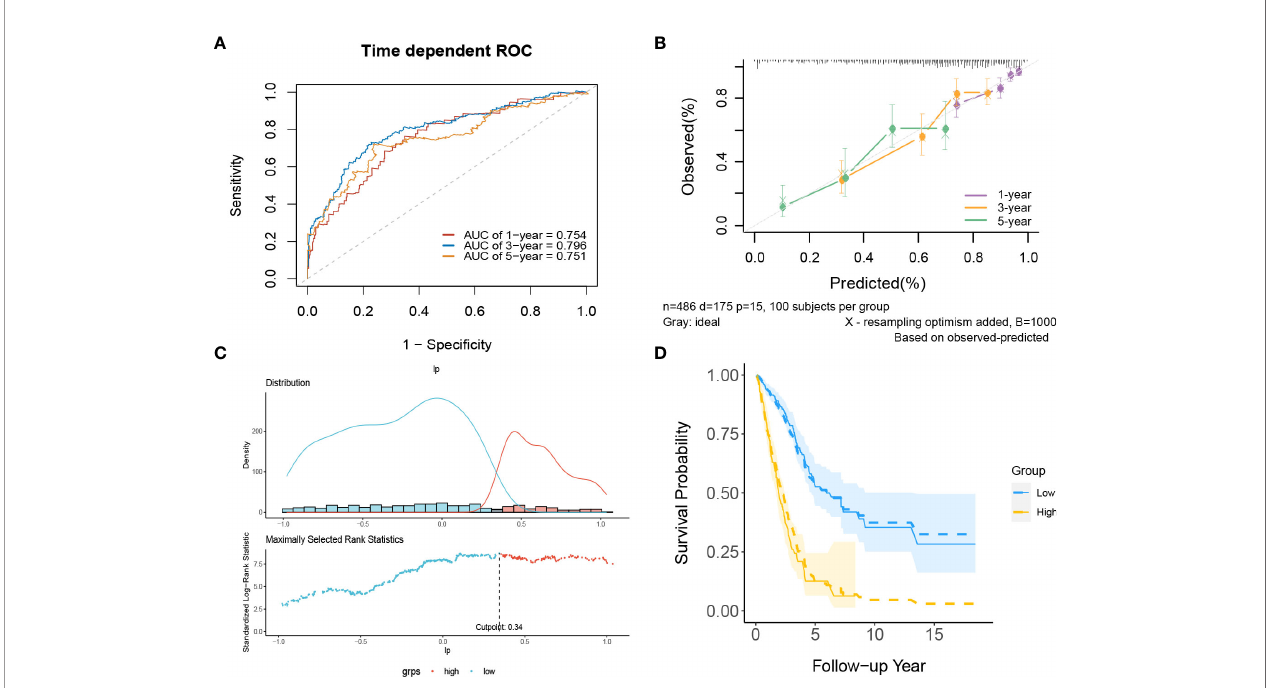
FIGURE 9 | The performance of the lncRNA model in the derivation dataset. (A) 1-,3-,5-year ROC curves and (B) calibration plot of the lncRNA model. (C) The optimal cutoff value of PI. (D) Predicted versus observed survival probability in each risk group. Solid line: observed Kaplan-Meier curve; dotted line: average predicted survival curve; shaded area: 95% con fi dence interval of observed survival probability.